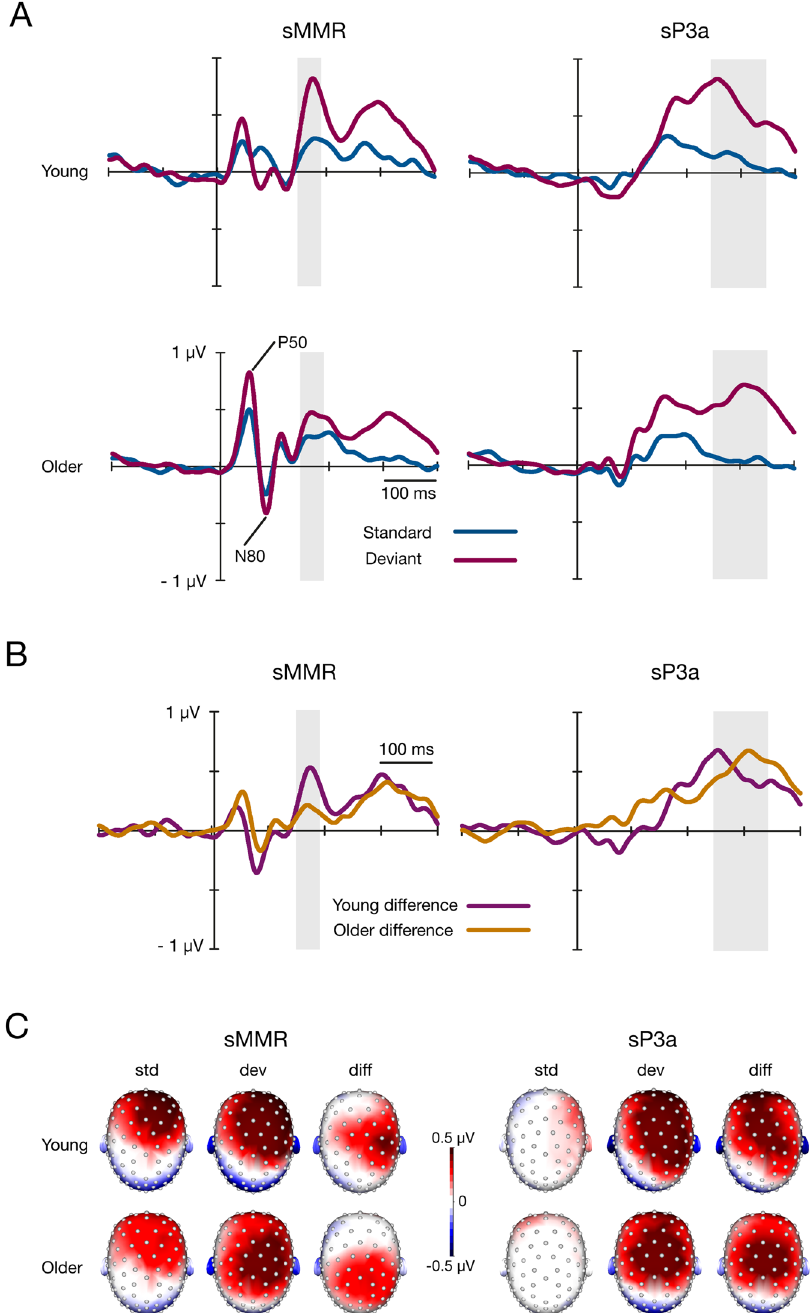
Figure 1. ( A ) Grand-averaged ERPs to somatosensory standard and deviant stimuli for young and older adults and ( B ) the differential waveforms (standard minus deviant) for young and older adults. Waveforms represent averages of the electrode pools applied in the analyses. The grey area shows the latency range of 153–193 ms for sMMR and of 258–358 for sP3a, from where the averaged amplitude values were extracted to analyse each ERP component. ( C ) The scalp voltage distributions of responses to standard (std) and deviant (dev) stimuli and differential responses (diff) (deviants minus standards). The topographic maps are shown as average voltages from 153–193 ms for sMMR and from 258–358 for sP3a. Note, due to keeping the scaling equal throughout, the lateralisation of differential response in older adults is no longer observable in the scalp topography of